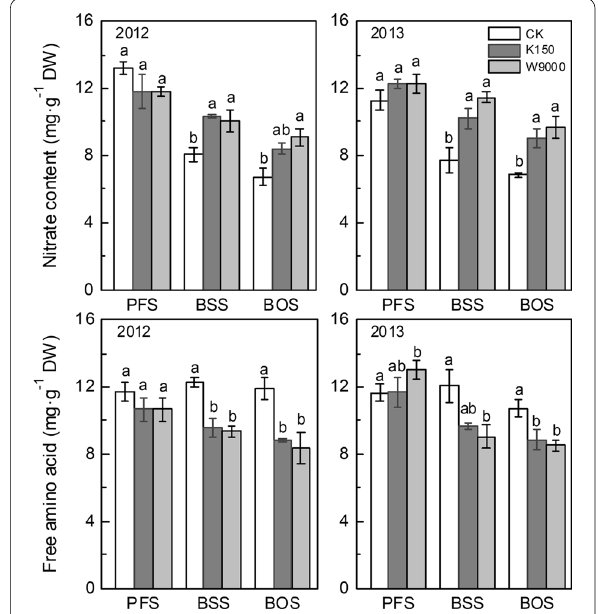
Fig. 4 Effects of straw-returning and inorganic K fertilizer on Fig. 5 Effects of straw-returning and inorganic K fertilizer on soluble nitrate and free amino acid contents in the functional leaf at the sugar/free amino acid ratio and C/N ratio in the functional leaf at peak flowering (PFS), boll-setting (BSS) and boll-opening (BOS) the peak flowering (PFS), boll-setting (BSS) and boll-opening (BOS) stages of Siza 3 in 2012 and 2013. The data are means of three stages of Siza 3 in 2012 and 2013. The data are means of three replications standard error. For each growth stage, bars bearing ± replications standard error. For each growth stage, bars bearing different letters are significantly different at P 0.05 ± = different letters are significantly different at P =